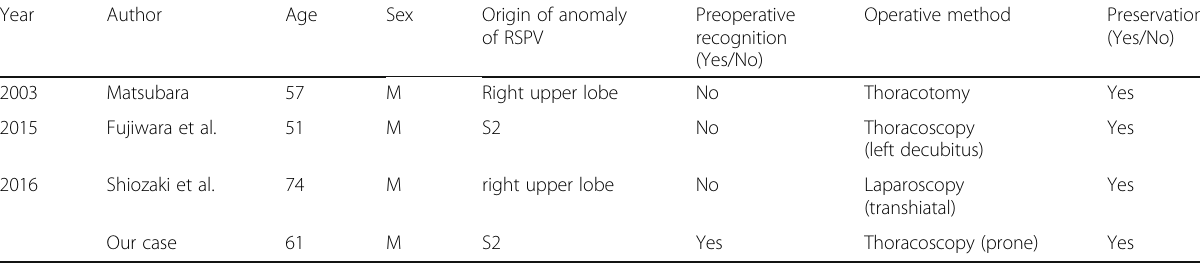
RSPV right superior pulmonary vein, S2 posterior segment of the right upper